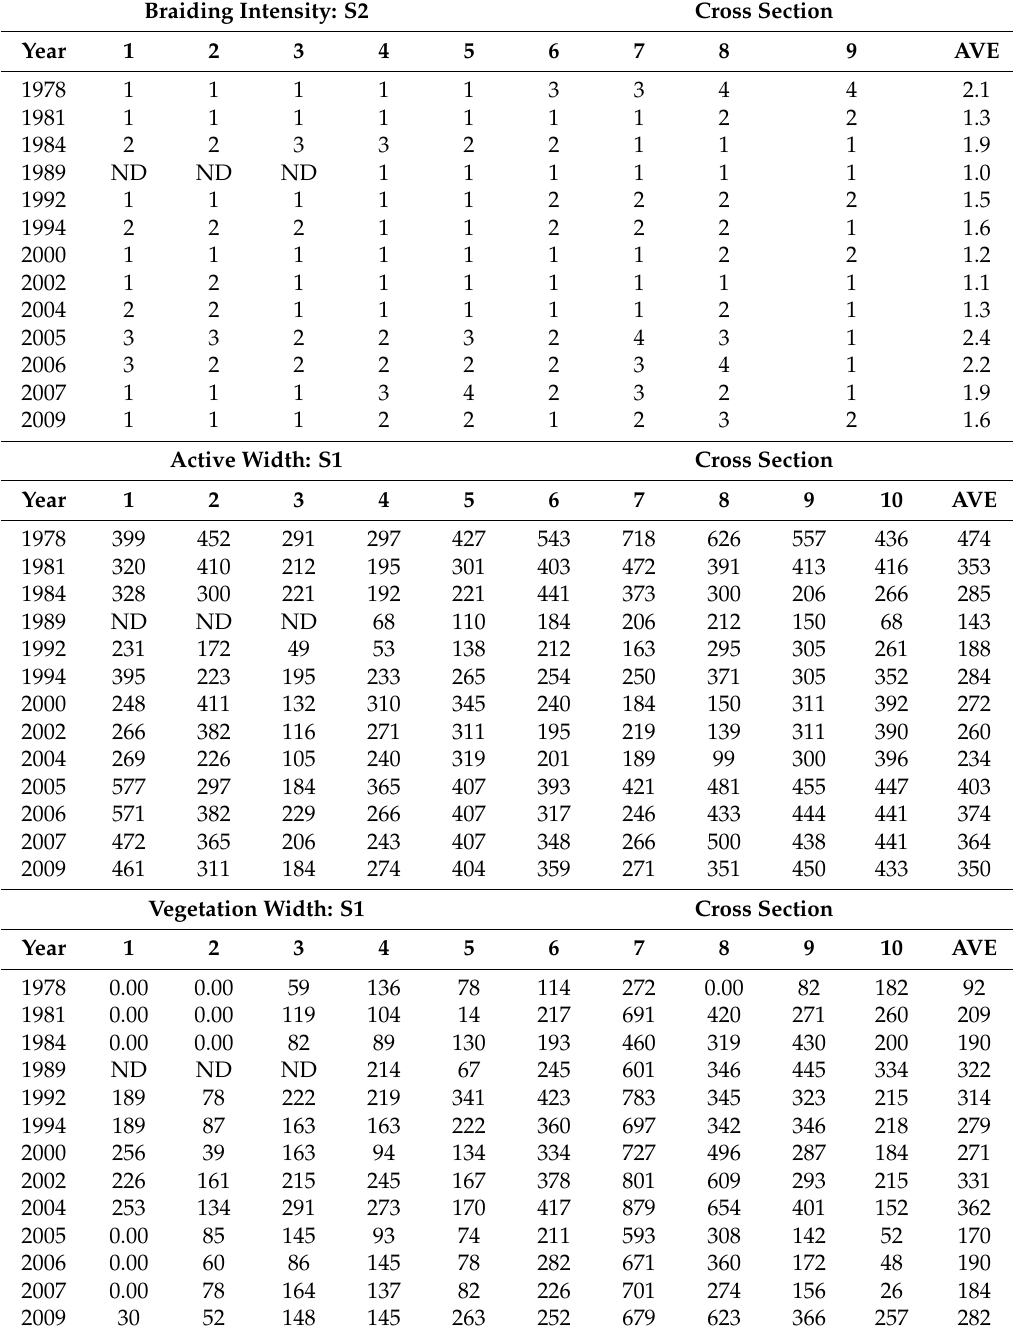
Table A3. Summary of measurements made from cross sections for aerial photos from site S1 of intensity of braiding (mean number of channels), active width (m) and vegetation width (m). ND is no data. Locations of cross sections are shown on Figure